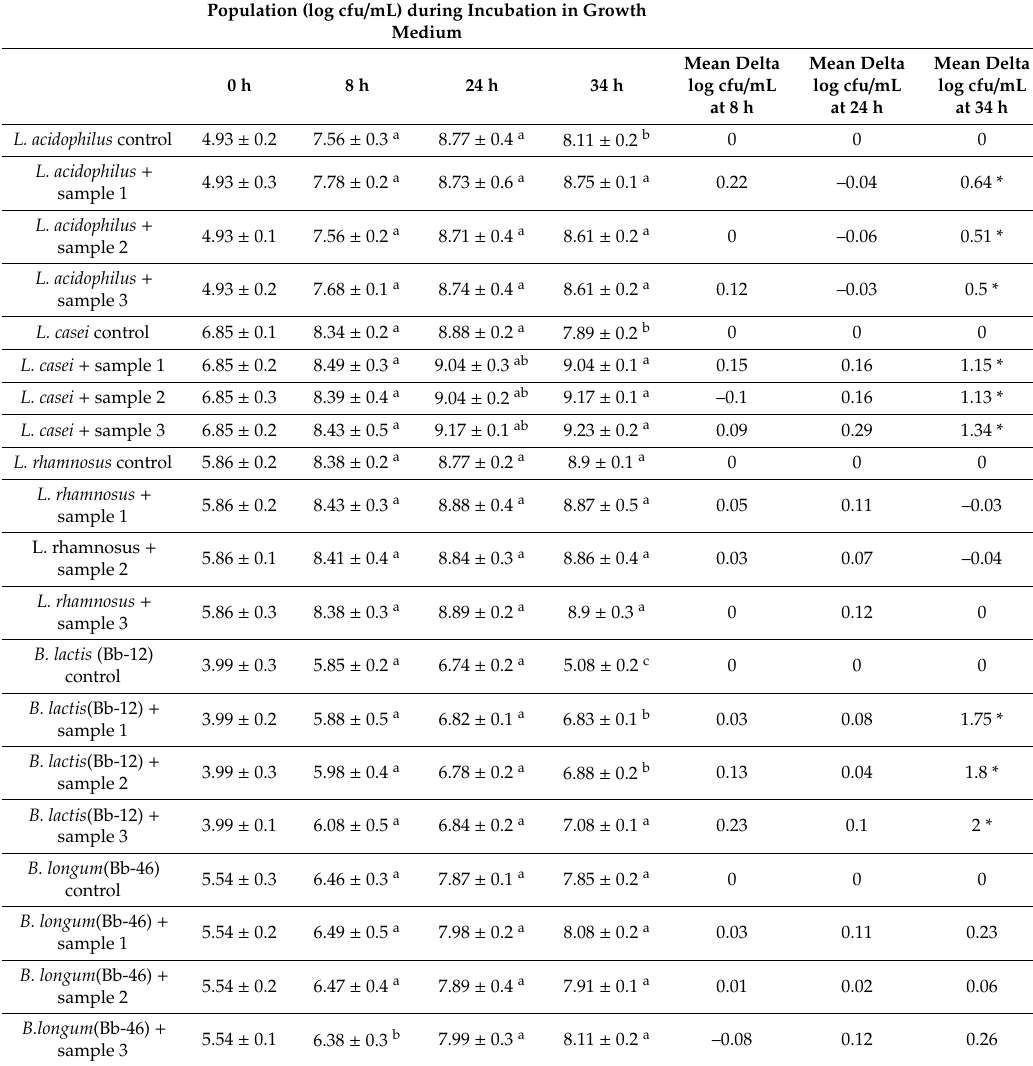
Table 3. Population (log cfu / mL) of probiotic bacteria in synthetic growth medium without (control) or with the addition of encapsulated Goji berry extracts (samples